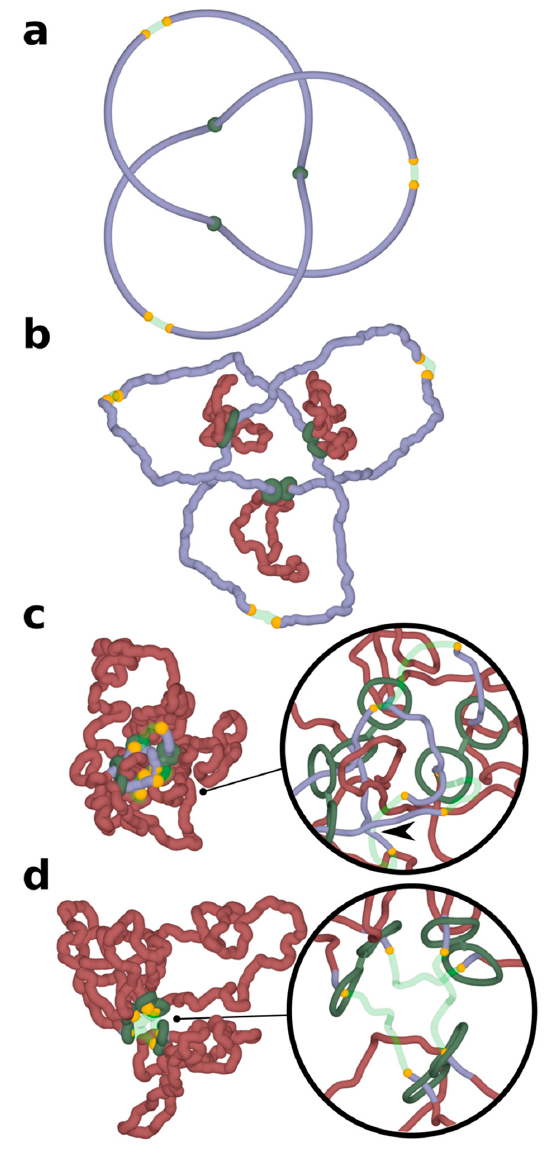
Figure 2. Chromatin loop extrusion unknots a delocalized trefoil knot spanning a modelled chromosome portion containing three TADs. Three TADs, each with two cohesin rings forming handcuffs (green), beads mimicking action of CTCF (yellow) and TopII sites (green semi-transparent) are modelled as presented in Figure 1. ( a ) The starting configuration shows that the formed trefoil knot is not localized within an individual TAD, but diffuses over three TADs. ( b – d ) Chromatin loop extrusion proceeds in all three TADs. The knot becomes excluded from the extruded chromatin portions and is concentrated in the chromatin portions with TopII sites of action, which are modelled as regions with reduced excluded volume potential. As the knot becomes more confined, it is more likely to interact with topoisomerases localized outside of TADs and is eventually unknotted there. Insets show close-ups of regions near TADs borders. For better visibility, the diameter of modelled chromatin fibres and cohesin handcuffs is decreased. In the inset shown in ( c ), the arrow indicates an unknotting passage involving a region with reduced excluded volume potential (semitransparent) and a chromatin portion that did not pass yet through cohesin rings (blue). In the inset shown in ( d ), the extrusion is nearly finished as cohesin rings are approaching sites with bound CTCF (yellow). The portion of chromatin, which will not be extruded further, is already free from knots.